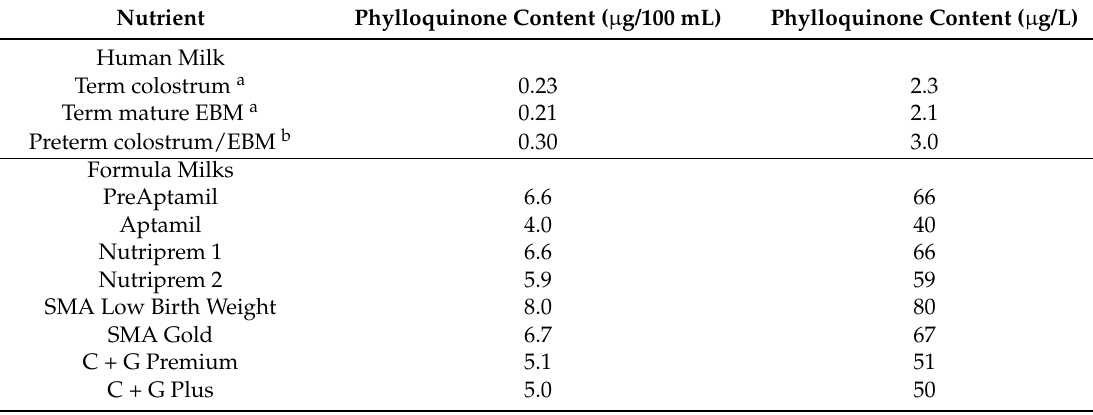
Table 1. Phylloquinone content of human milk, commercial milk formulae, and fortifiers.